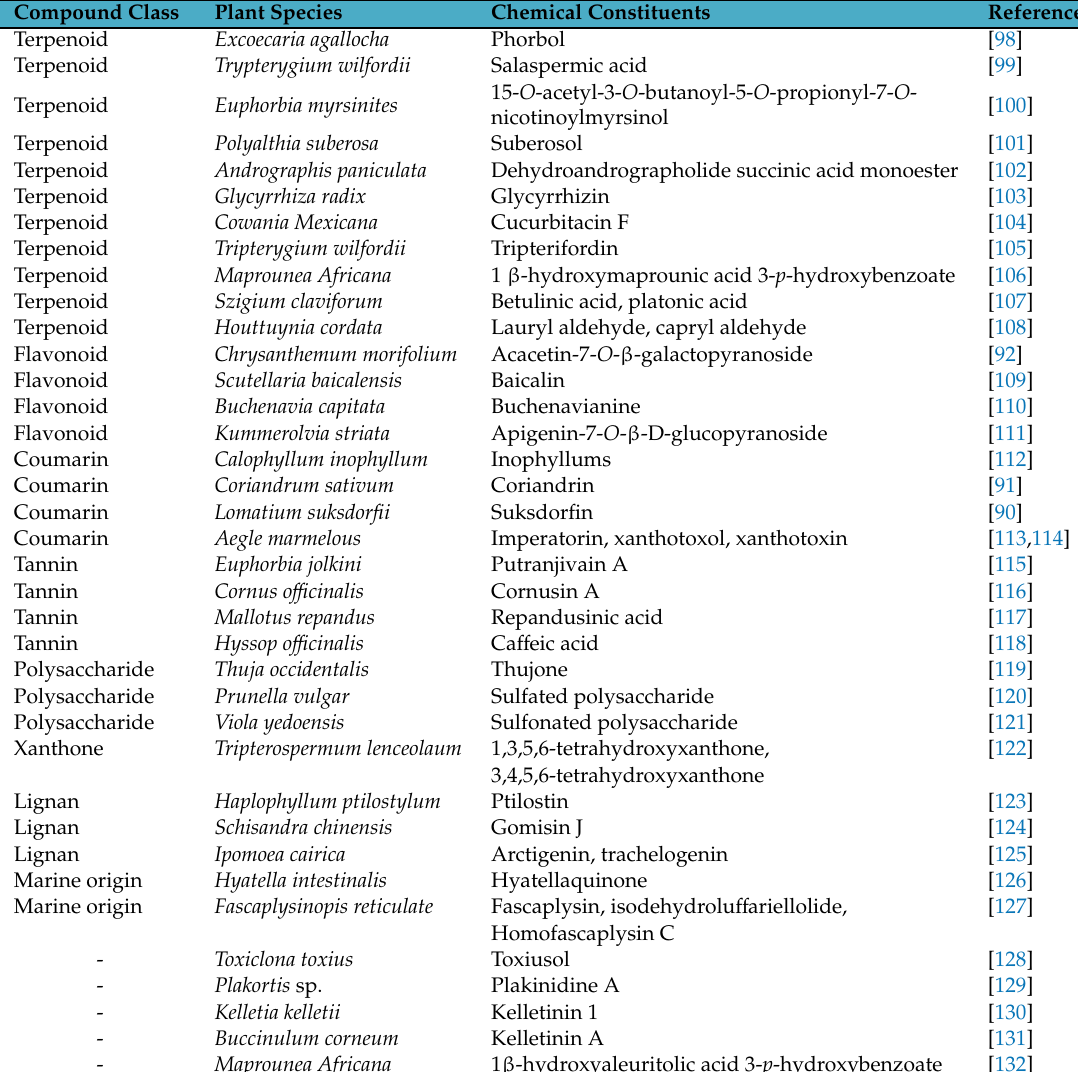
Table 1. Plant-based reverse transcriptase